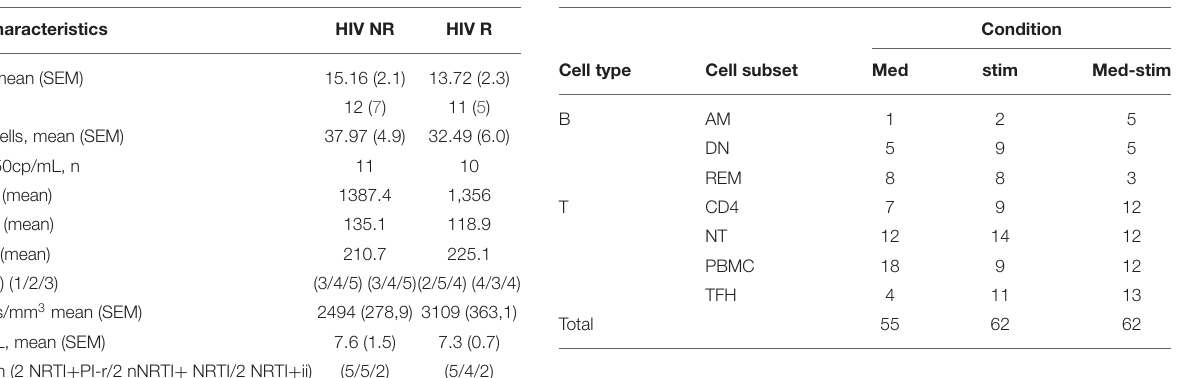
TABLE 2 | Selected genes and